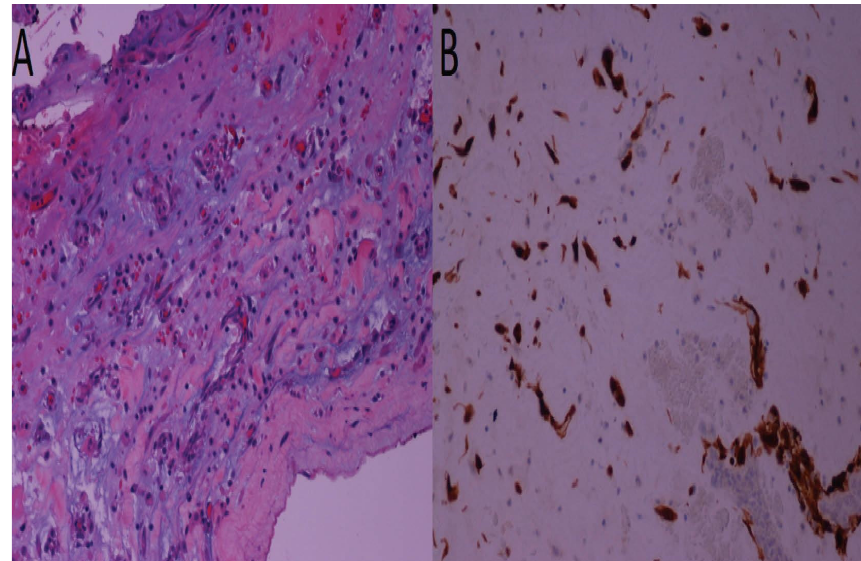
Figure 6: (a) Hematoxylin and eosin stain at 20x magnifcation with basophilic matrix, few spindle cells with no mitotic activity. (b) Calretinin immunoreactivity at